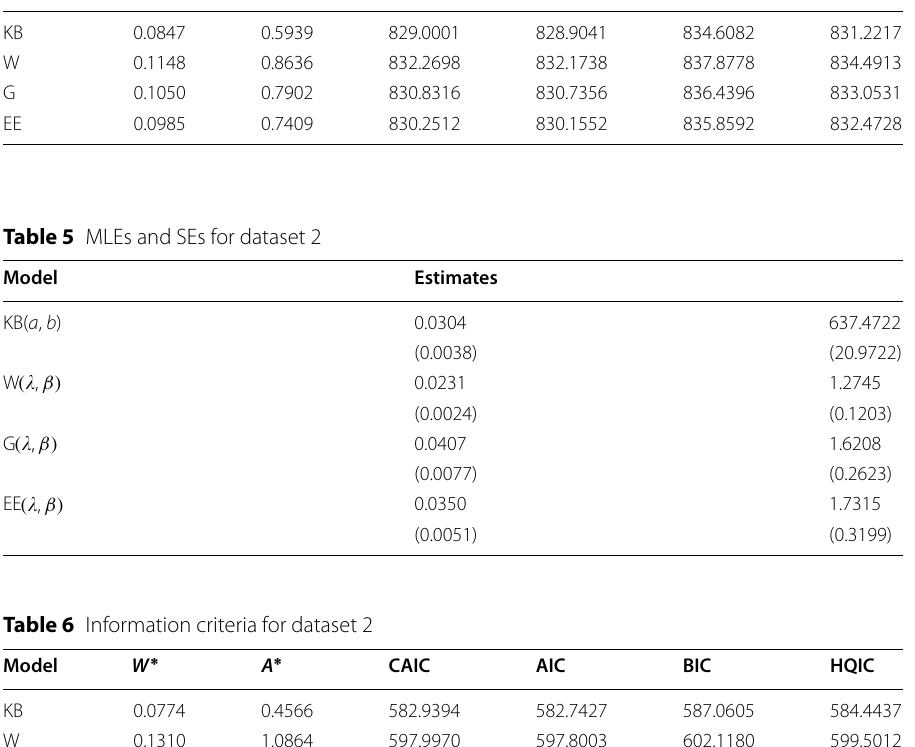
Table 4 Information criteria for dataset 1 Model